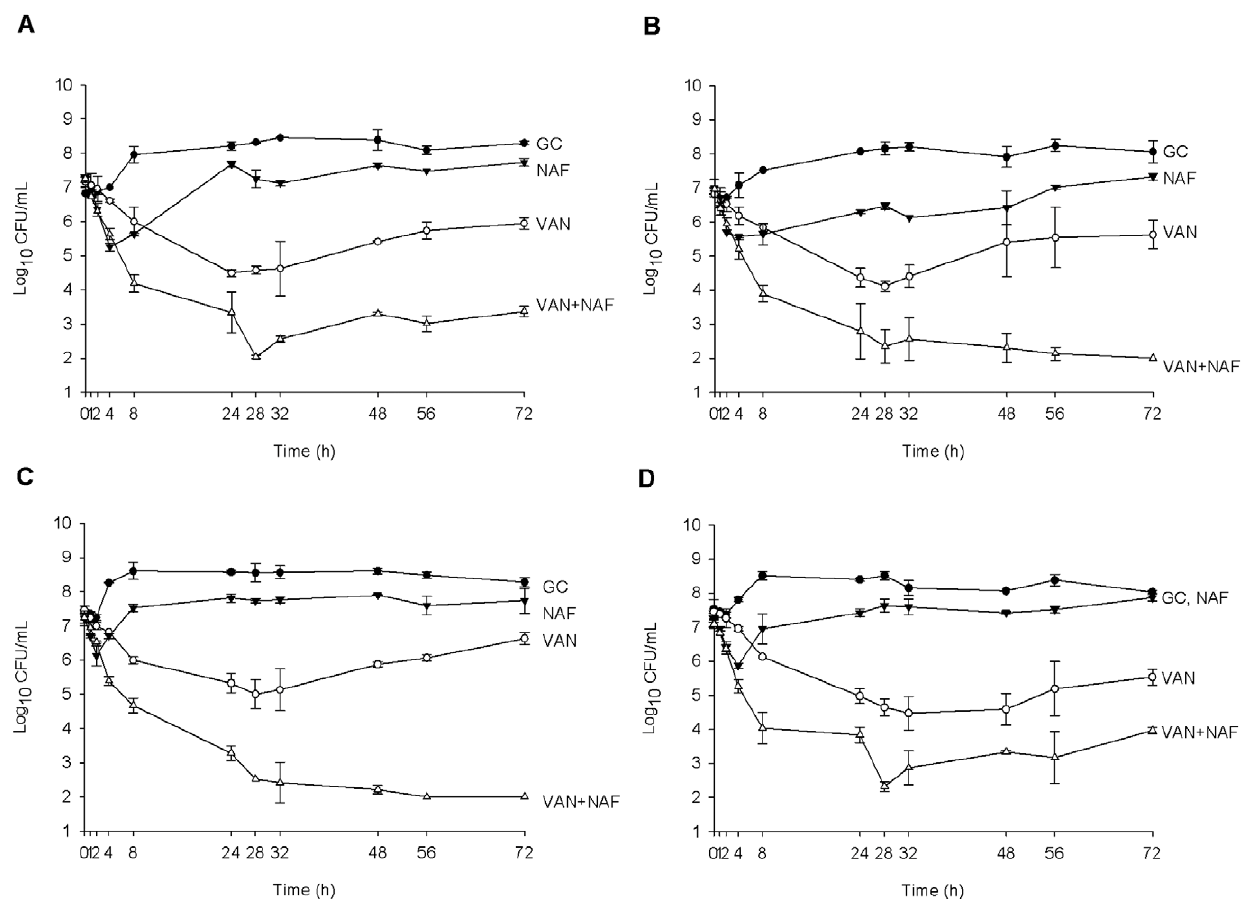
Figure 2. Activity of vancomycin and nafcillin alone and in combination in the PK/PD model against hVISA strains where the concentration of nafcillin was below the MIC of the respective organism for 100% of the dosing interval. Graphs shown are of isolate R5253 (Nafcillin MIC=16 m g/mL) (A), R1915 (Nafcillin MIC=64 m g/mL) (B), R2729 (Nafcillin MIC=128 m g/mL) (C), and R3003 (Nafcillin MIC=256 m g/ mL) (D). Data are presented as a graph of the mean bacteria remaining vs. time with error bars at the sampling points representing 1 standard deviation from the mean. GC=Growth Control, NAF=Nafcillin, VAN=Vancomycin.